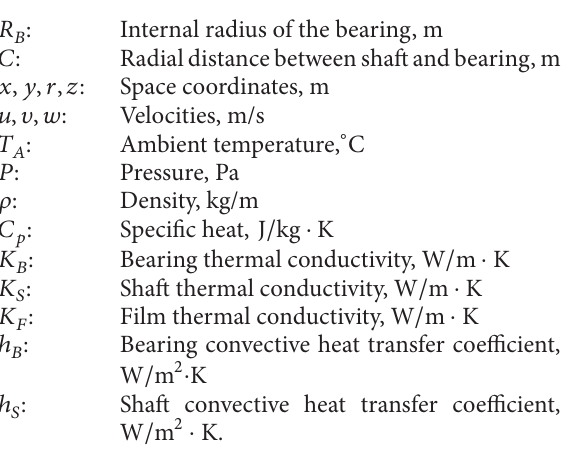
Figure 17: Evolution of the lubricating film temperature according to its thickness at the central plan of the journal bearing and for different values of 𝑛 .